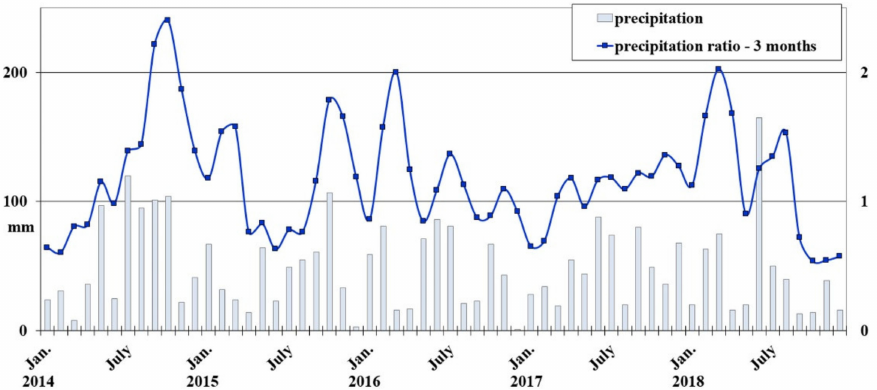
Figure 2. Precipitation amount and three-month precipitation ratio from 2014 to 2018 at the Kecskem é t station: the ratio presents the normalization of the sum of one month’s precipitation and that of the two preceding months to the sum of the normal value (1971–2000) of this three-month amount of precipitation; the value 1 denotes the average data (data: Hungarian Meteorological